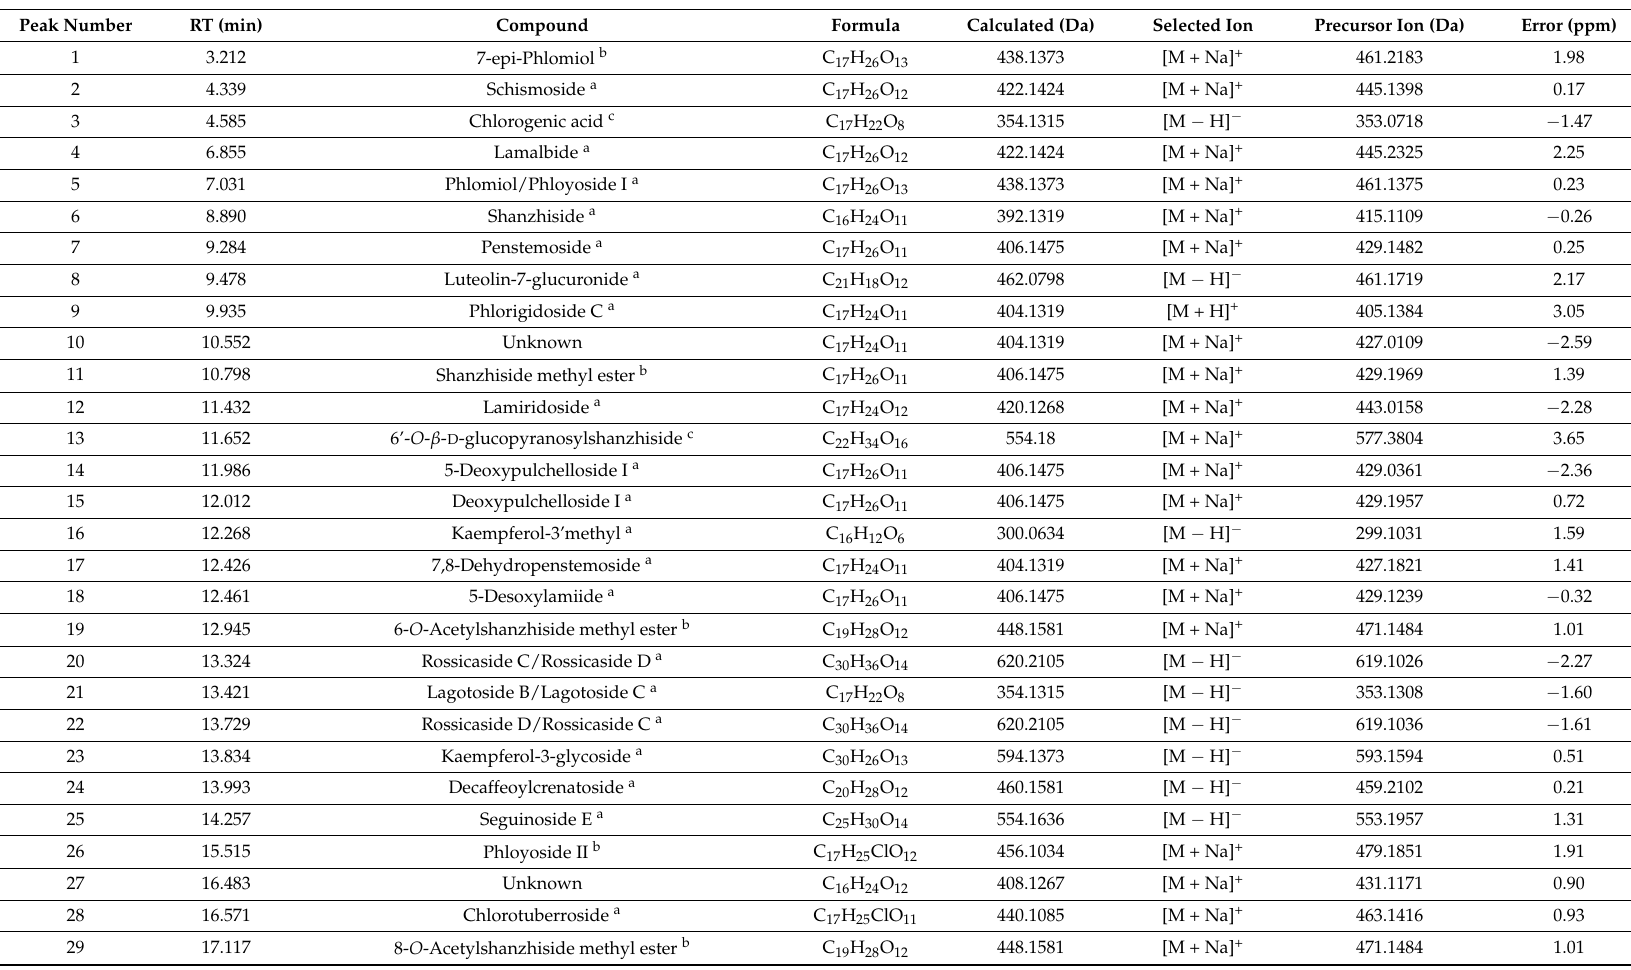
Table 2. The Identification constituents of the constituents in L. rotate by ultra-high-performance liquid chromatography coupled with time-of-flight mass spectrometry (UPLC-QTOF-MS)